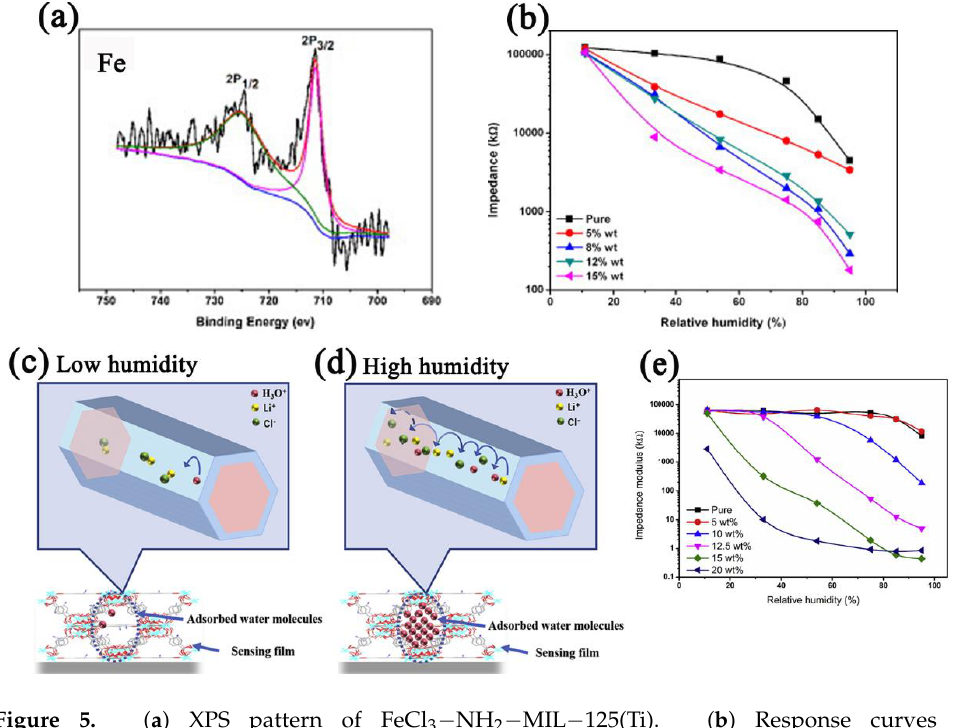
Figure 5. ( a ) XPS pattern of FeCl 3 − NH 2 − MIL − 125(Ti). ( b ) Response curves of FeCl 3 − NH 2 − MIL − 125(Ti) − based humidity sensors to humidity in the range of 11 – 95% RH. Reproduced with permission from Ref. [81]. Copyright 2014, Elsevier. Schematic of conduction path of LiCl@UiO − 66 − NH 2 − based humidity sensor in ( c ) low humidity and ( d ) high humidity. ( e ) Response curves of LiCl@UiO − 66 − NH 2 − based humidity sensors to humidity in the range of 11 – 95% RH. Reproduced with permission from Ref. [53]. Copyright 2020, Elsevier.